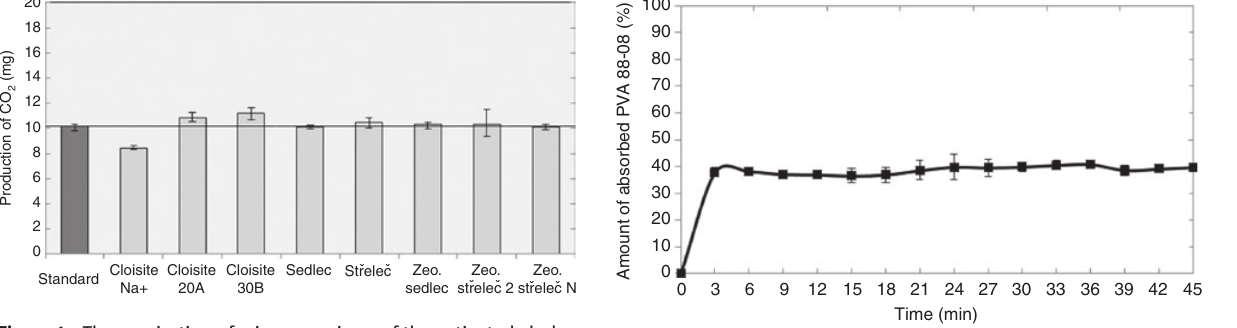
Figure 3: Kinetic trend of PVA 88-08 adsorption on Cloisite ® Na + ( ± standard